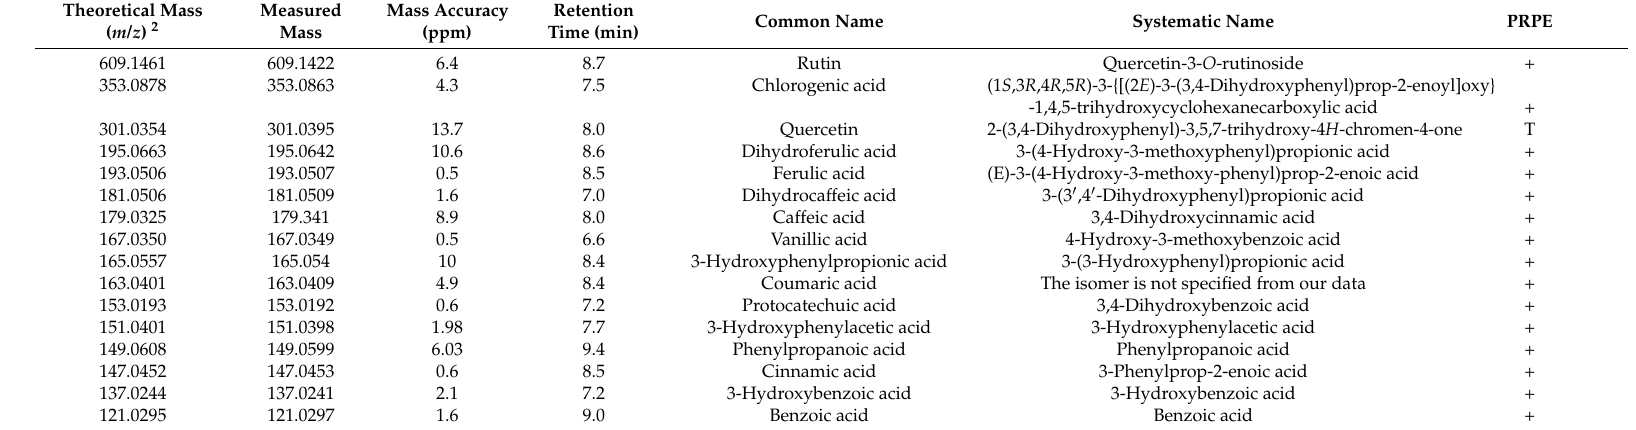
Table 1. Polyphenols and their metabolites after human simulated intestinal digestion of polyphenol-rich potato extract (PRPE) 1